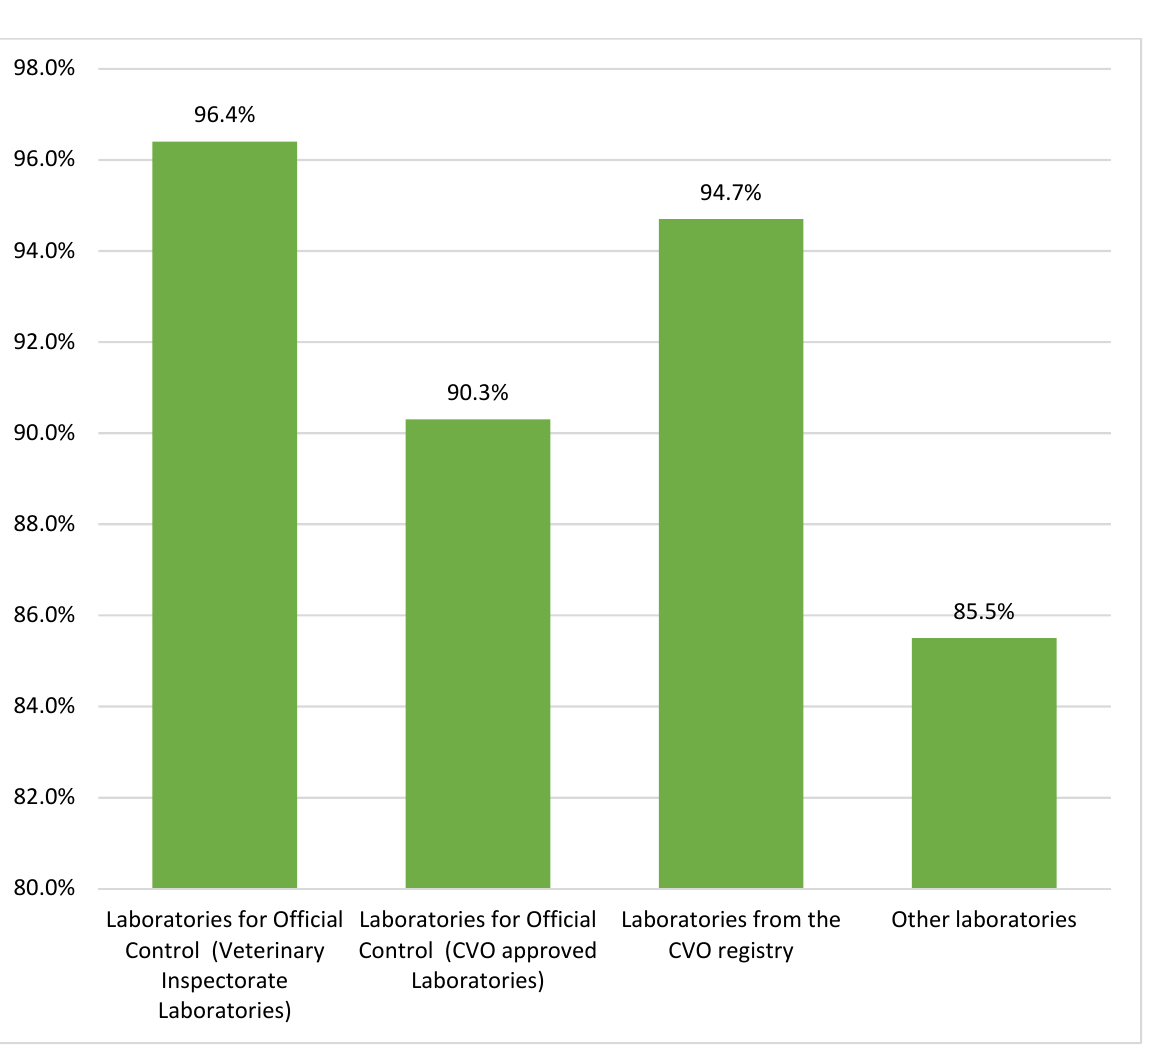
Figure 3. Percentage of laboratories with a positive evaluation in PT from raw milk samples in 2017– 2021.